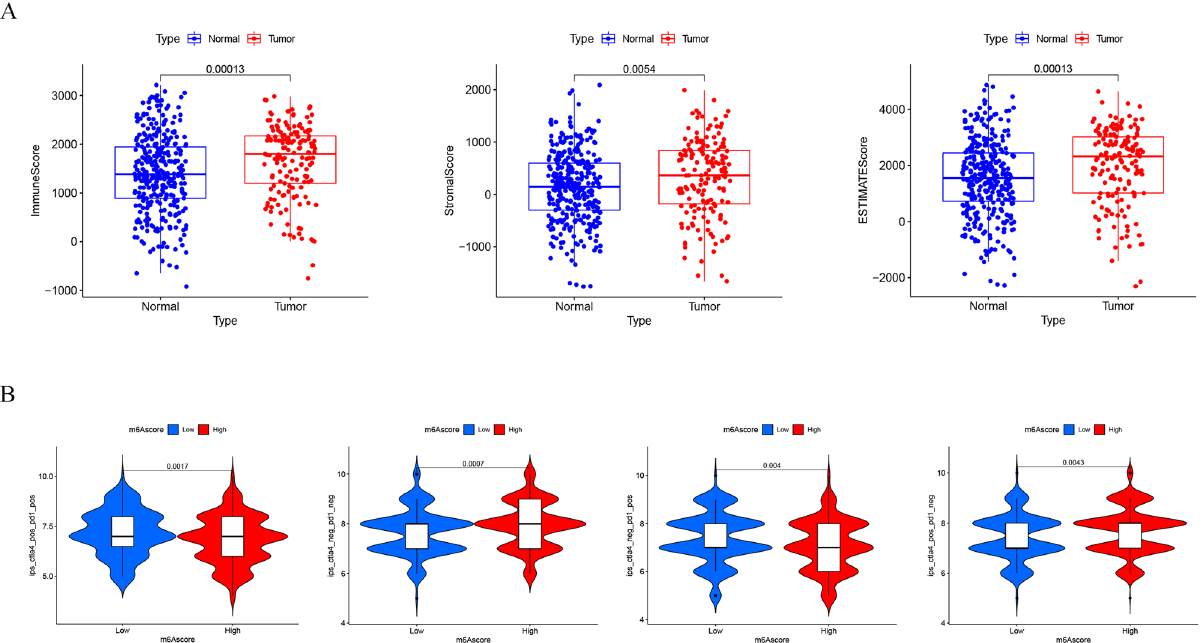
Figure 7. The role of m6Ascore in tumor microenvironment and immunotherapy. ( A ) The score levels of ImmuneScore, StromalScore, and ESTIMATEScore in the high- and low- m6Ascore groups. ( B ) The relative distribution of immunophenoscore (IPS) was compared between low- and high- m6Ascore